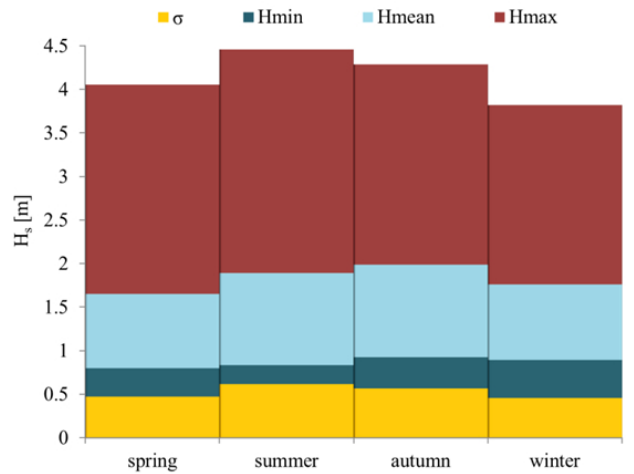
Figure 7. Seasonal wave climate characterization, in terms of significant wave height, averaged over 10 years at point P16.